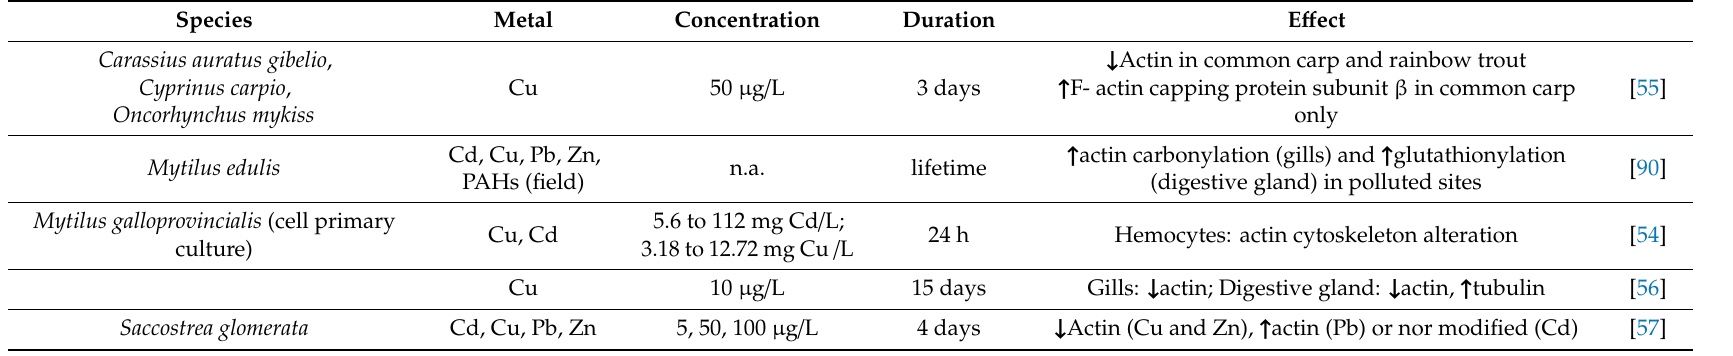
Table 3. Summary of studies describing metal impacts on cytoskeleton rearrangement.